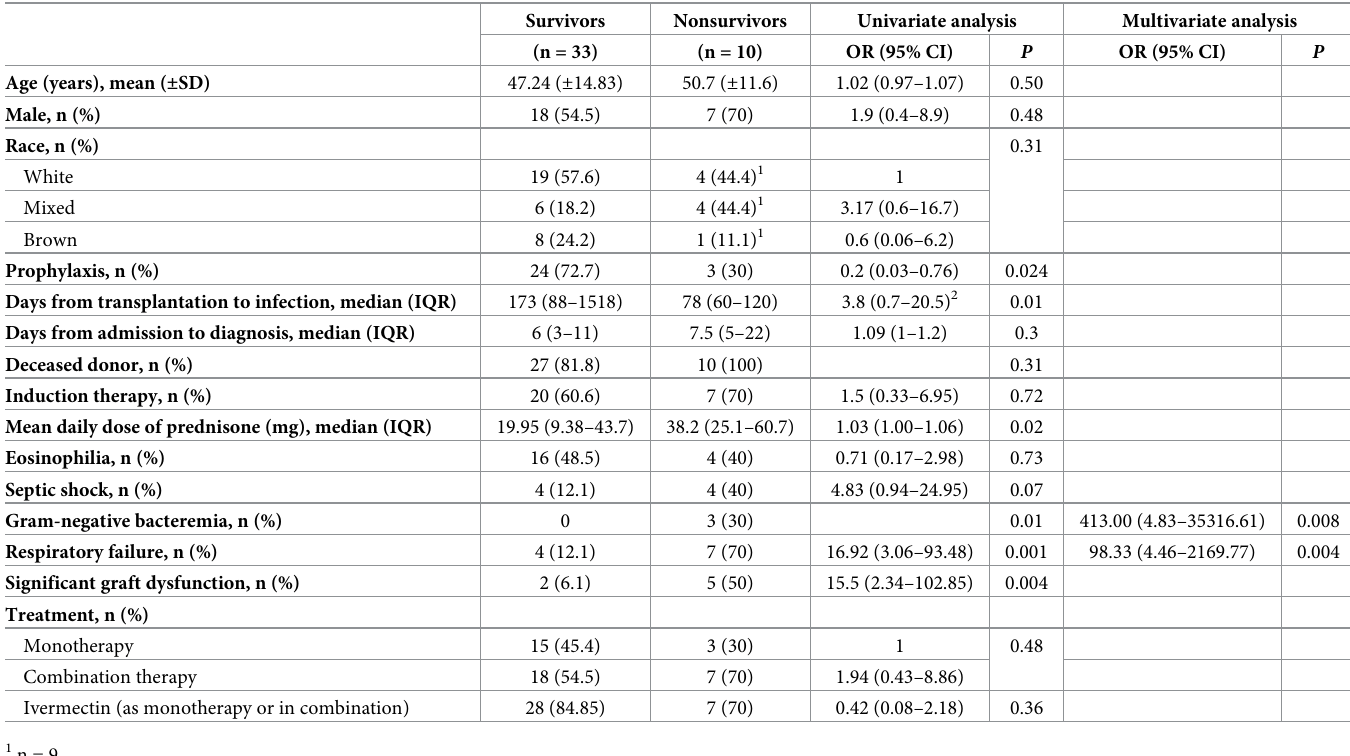
Table 6. Univariate and multivariate analysis of risk factors for 30-day mortality among treated patients with severe Strongyloides stercoralis